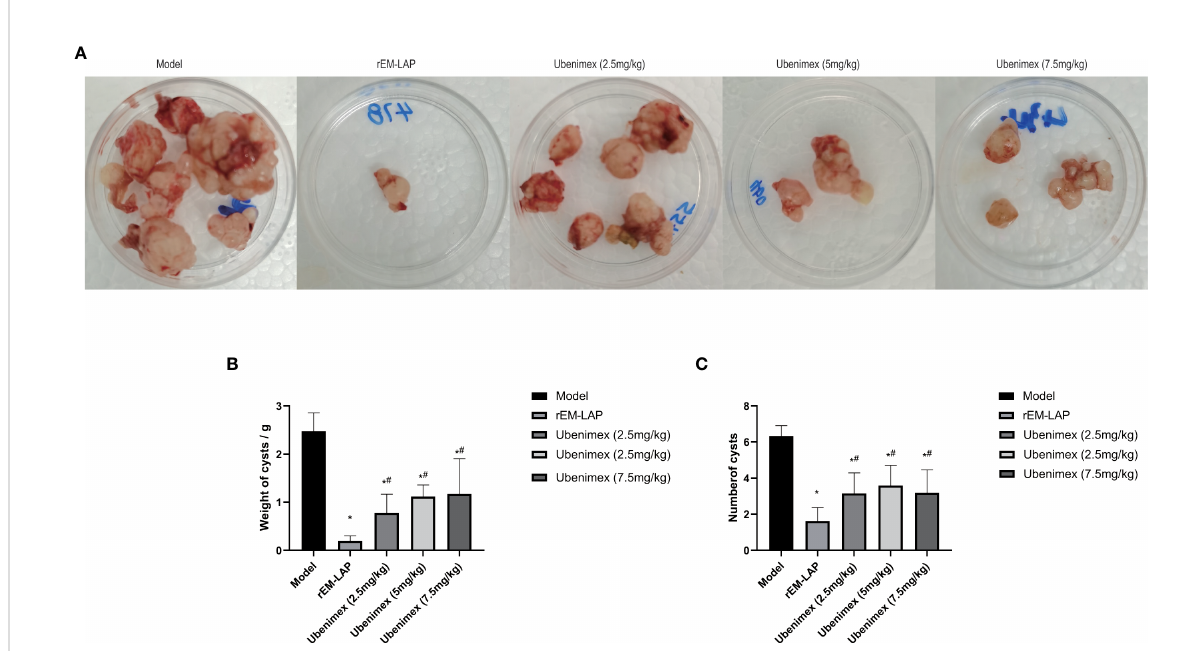
FIGURE 4 Therapeutic effect of rEM-LAP. (A) The size and number of cysts at week 17. (B) The weight of cysts in different groups. (C) The number of cysts in different groups. (* p<0.05 v.s. Model group; #: vs p<0.05 v.s. rEM-LAP group. n=6, a